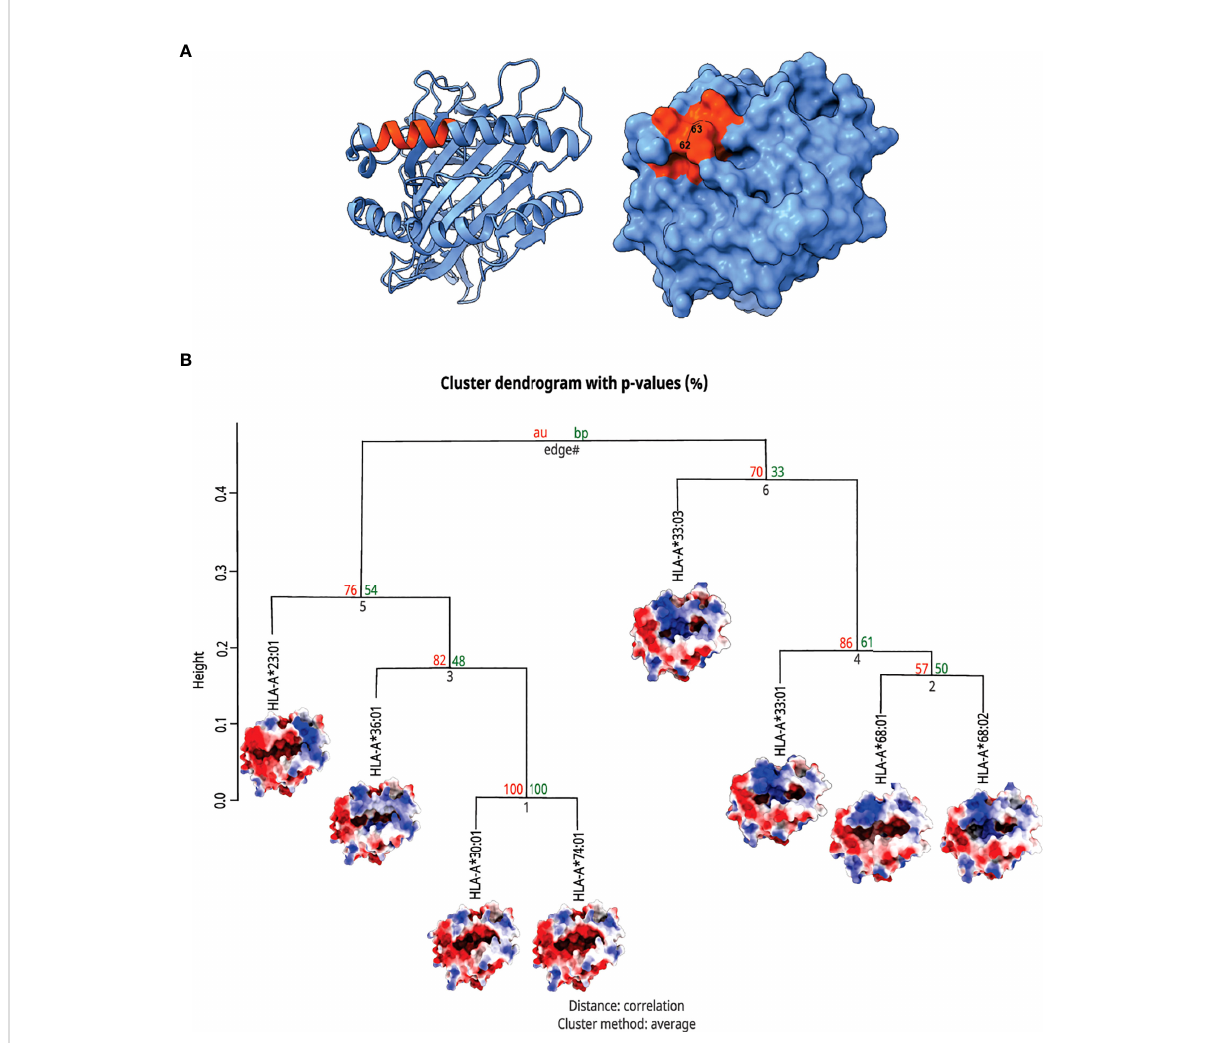
FIGURE 4 Top view of HLA-A molecules and hierarchical clusterization of HLA-A alleles. In (A) there is a MHC structure in both the ribbon and surface visualizations from the region that interacts with the TCR, respectively. The area in orange represents the zone proximal about the residues 62 and 63. In (B) we can see the cluster dendrogram of the analyzed MHCs. Under each allele name, there is the surface image that was generated for electrostatic potential distribution. In the right branch, we can see the cluster of alleles carrying rs199474424 (please refer to Figure 2), HLA- A*33:01, A*33:03, A*68:01, and A*68:02, with their respective shared molecular fi